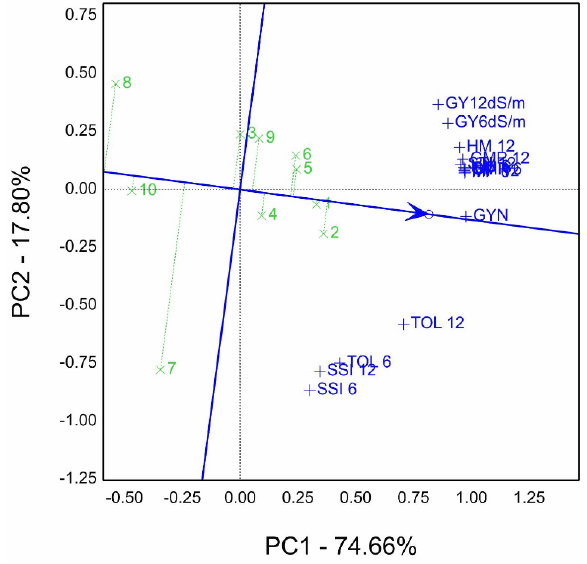
Figure 13. Mean vs stability (GSTI) biplot of ranking genotypes based on grain yield gm per row (GYN), grain yield gm per row (GY 6.0, 12.0 dS/m), and salinity tolerance/susceptible indices (calculated at control with 0.4 dS/m and 6.0 dS/m and 12.0 dS/m) of ten genotypes in the 2020/21 season. TOL, tolerance index; MP, mean productivity; STI, stress tolerance index; GMP geometric mean productivity; HM, harmonic mean; SSI, stress susceptibility